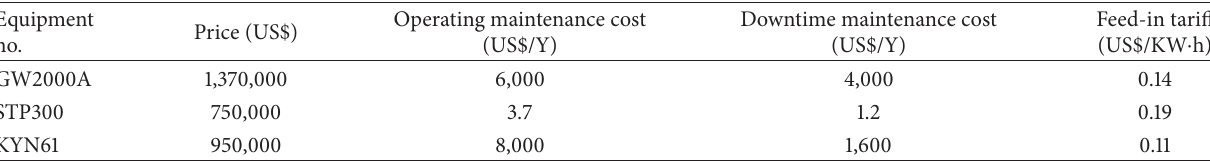
Table 2: Economic parameters.